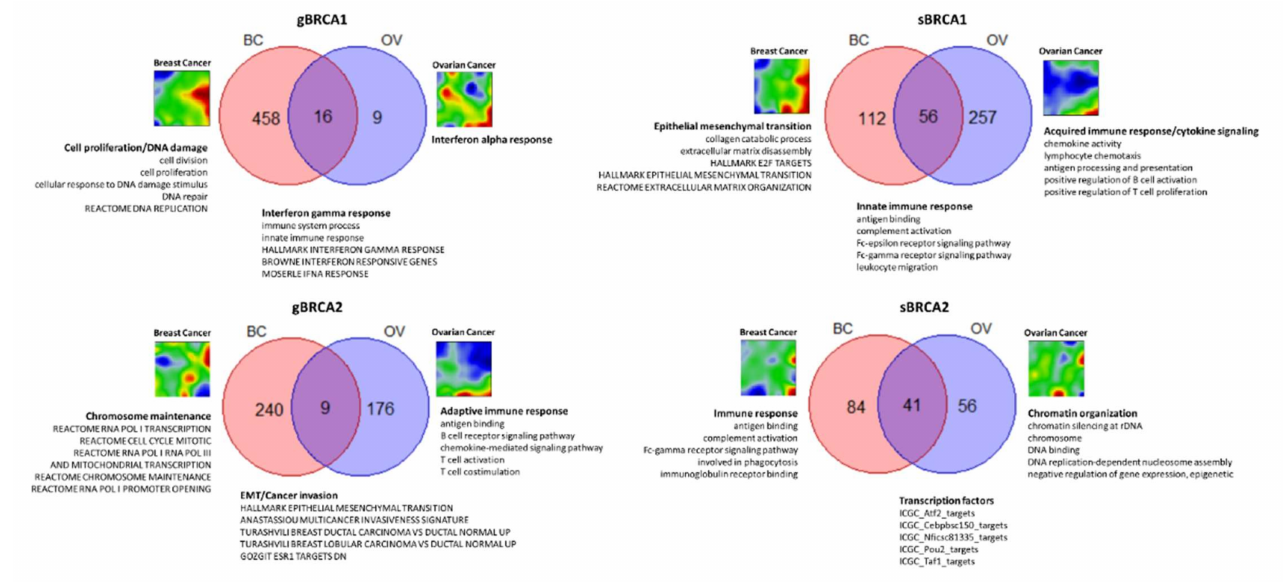
Figure 6. Overlap of functional gene sets upregulated in mutation associated group transcriptome landscapes in breast (BC) and ovarian (OV)